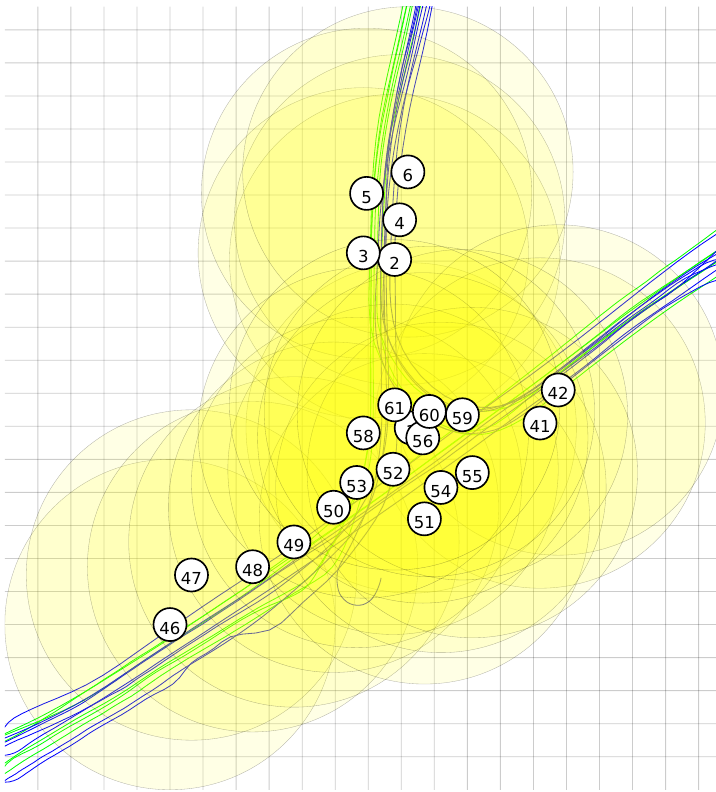
Figure 4. Detection areas for a radius of 100 m and vehicle traces; grid size is 20